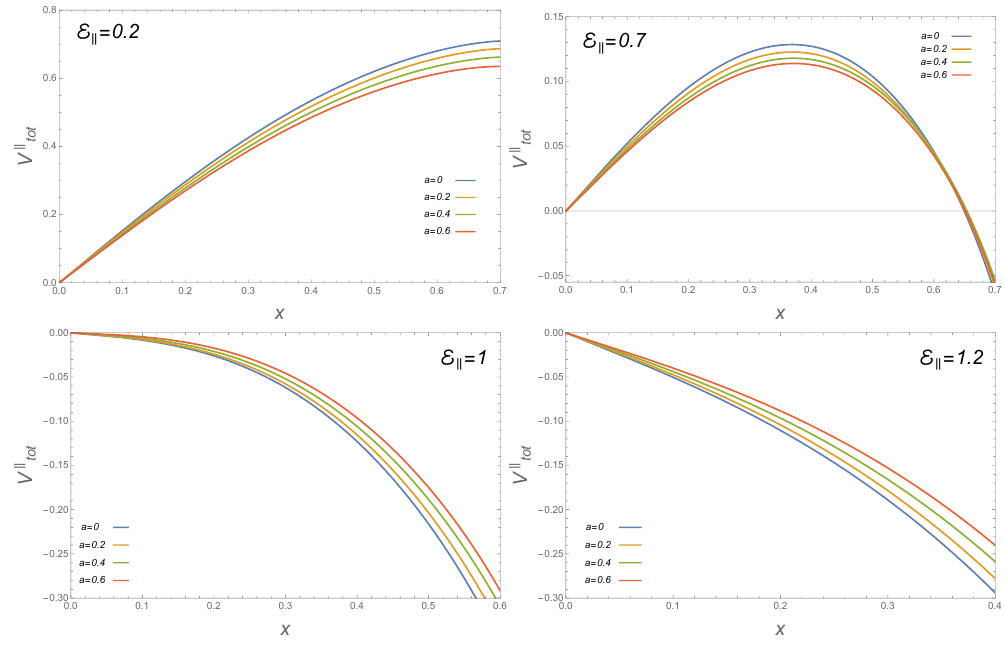
Figure 4 . The holographic potential V k fixed E in the black brane background. k